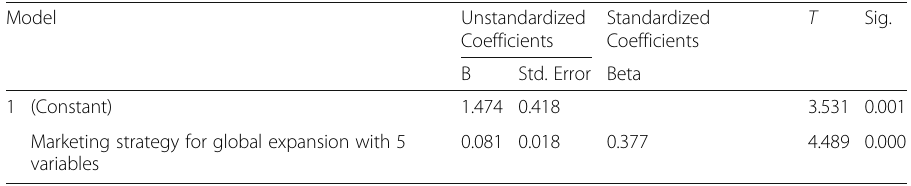
Table 12 Regression coefficients — marketing strategy Model Unstandardized